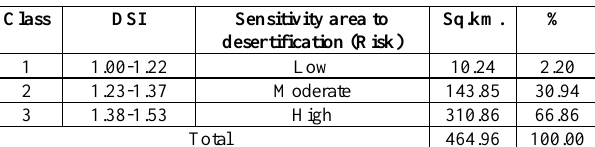
Table 9. Severity classes of desertification sensitivity index